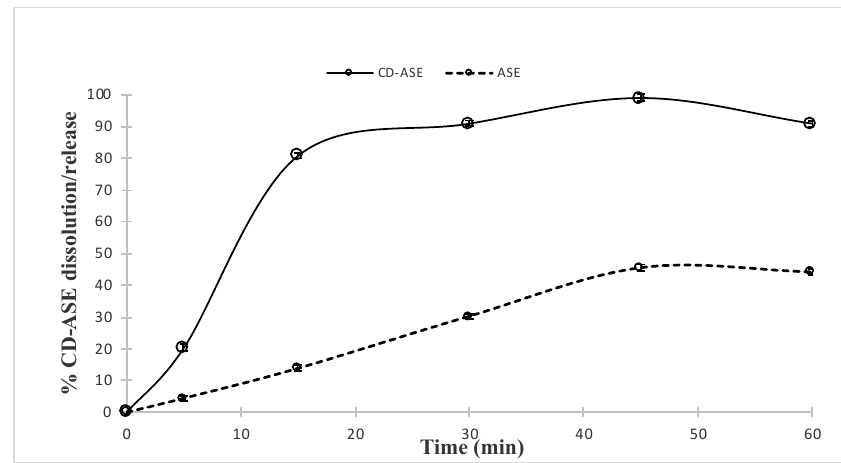
Figure 6. Dissolution/release profile of CD-ASE complex in comparison with ASE raw dissolution profiles in water.